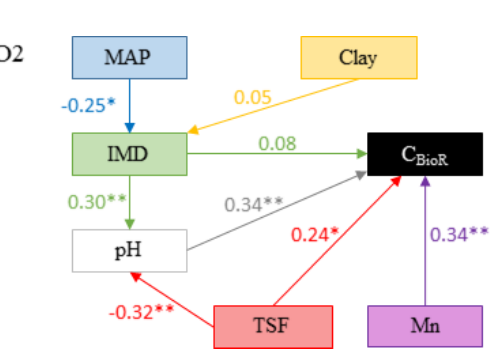
Figure 4. Model that best fitted the data to explain carbon biore- activity (C BioR ) in the O layer. Arrows indicate direct causal rela- tionships. The numbers are standardized averaged path coefficients obtained using model averaging (see Table S1 and text for further details). MAP: mean annual precipitation; clay: clay content in the top 35cm of mineral soil; Mn: exchangeable manganese; pH: pH of the O layer; TSF: time since fire; IMD: index of moss dominance. ∗ p < 0 . 05; ∗∗ p < 0 .